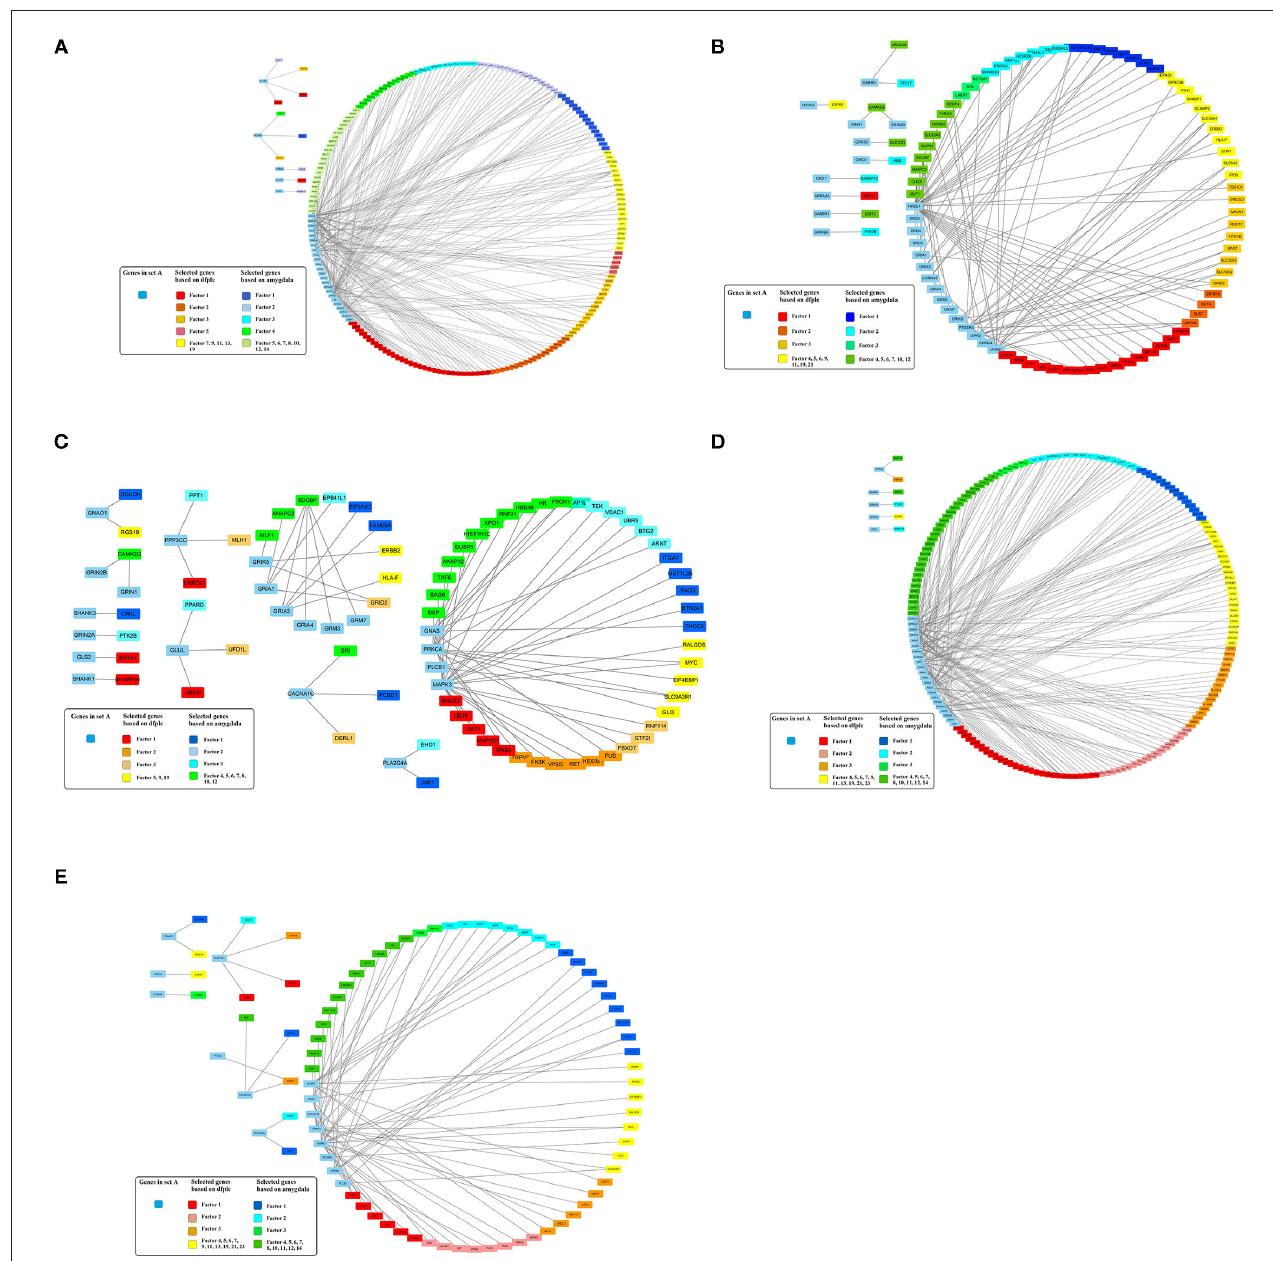
FIGURE 2 | Expanded schizophrenia-associated pathways using machine learning selected genes in dorsolateral prefrontal cortex union amygdala based on gene interaction database. (A) Dopaminergic synapse pathway. (B) Neuroactive ligand–receptor interaction. (C) Genes in glutamatergic synapse pathway. (D) cAMP signaling pathway. (E) Serotonergic synapse